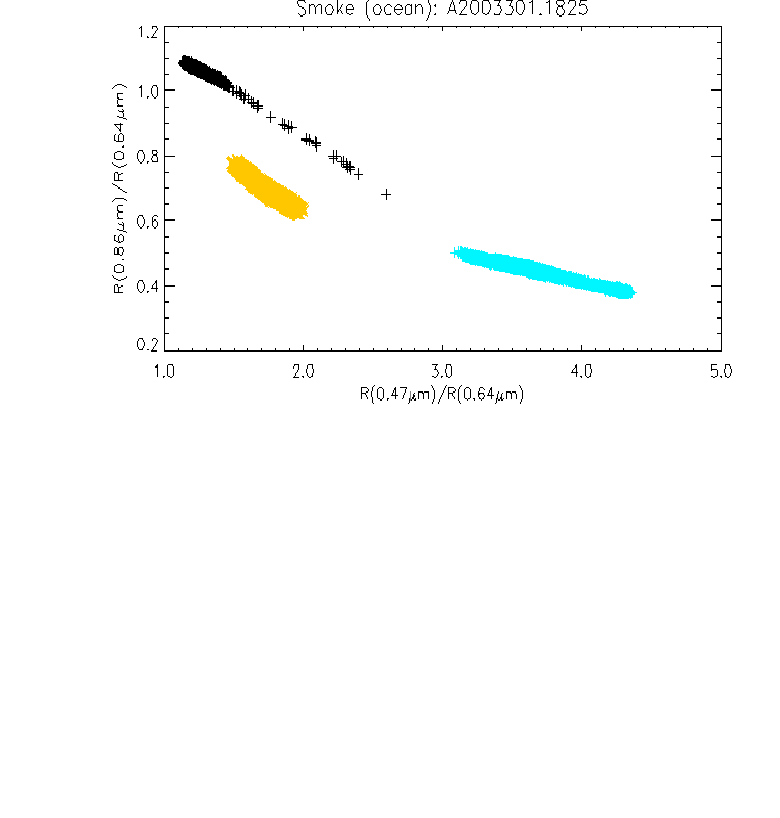
= R /R versus R = R /R for clear-sky 2 0.86  m 0.64  m 1 0.47  m 0.64  m